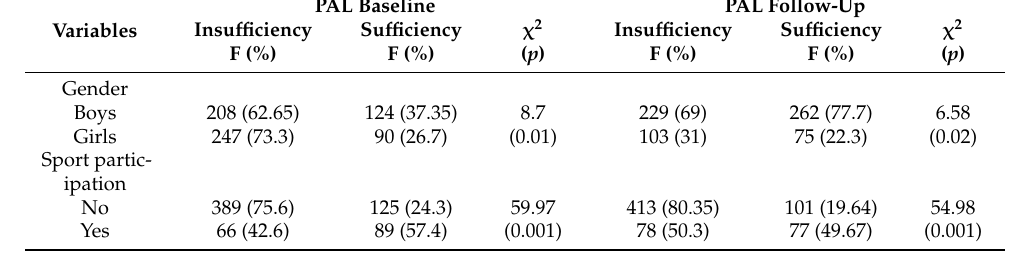
Table 1. Descriptive statistics (frequencies (F) and percentages (%)) and differences (Chi-square test- χ 2 ) between groups based in physical activity level (PAL) sufficiency/insufficiency.